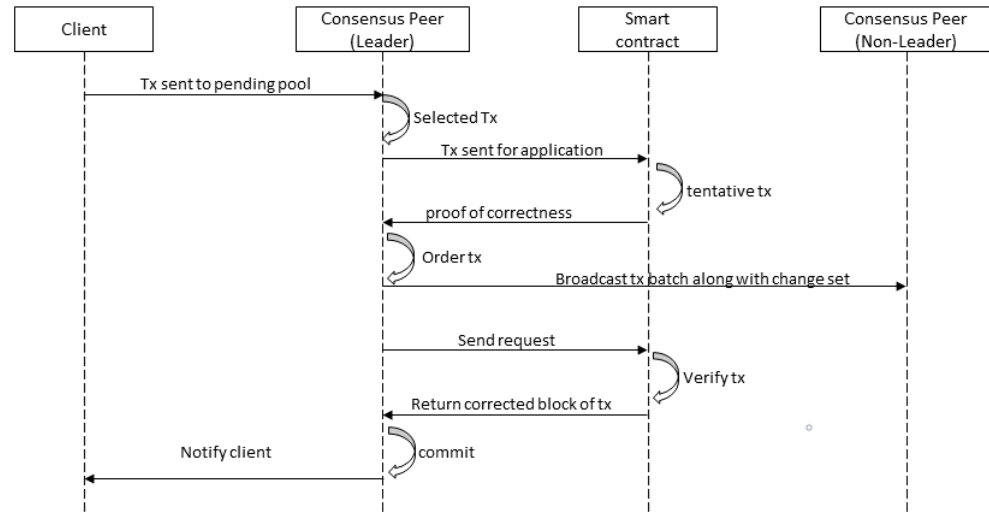
Figure 4. Sequence diagram for consensus in a private